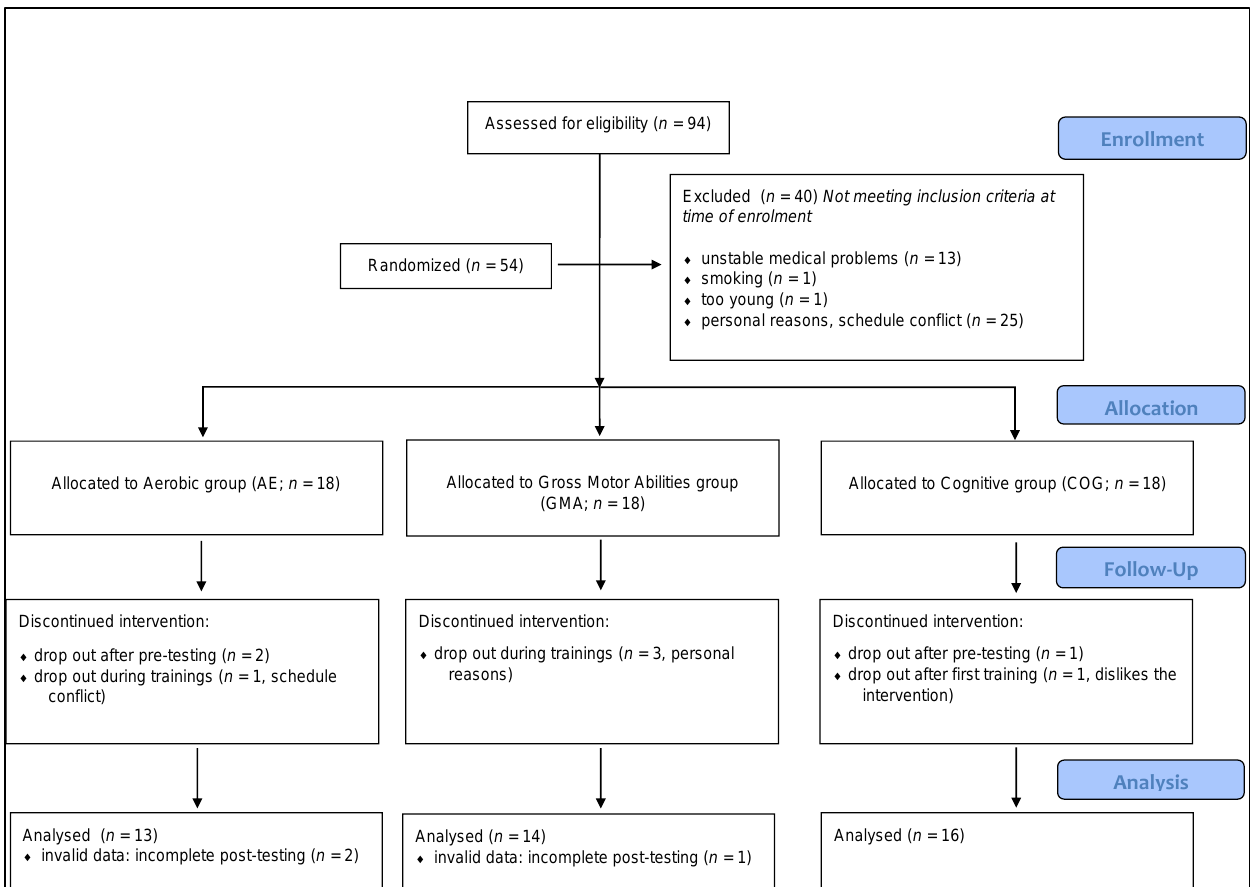
Figure 1. Randomization process of the study.